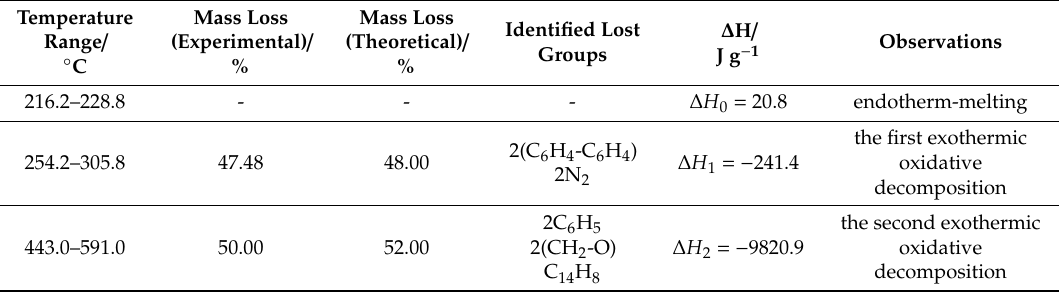
Table 13. Thermal analysis of BPA.